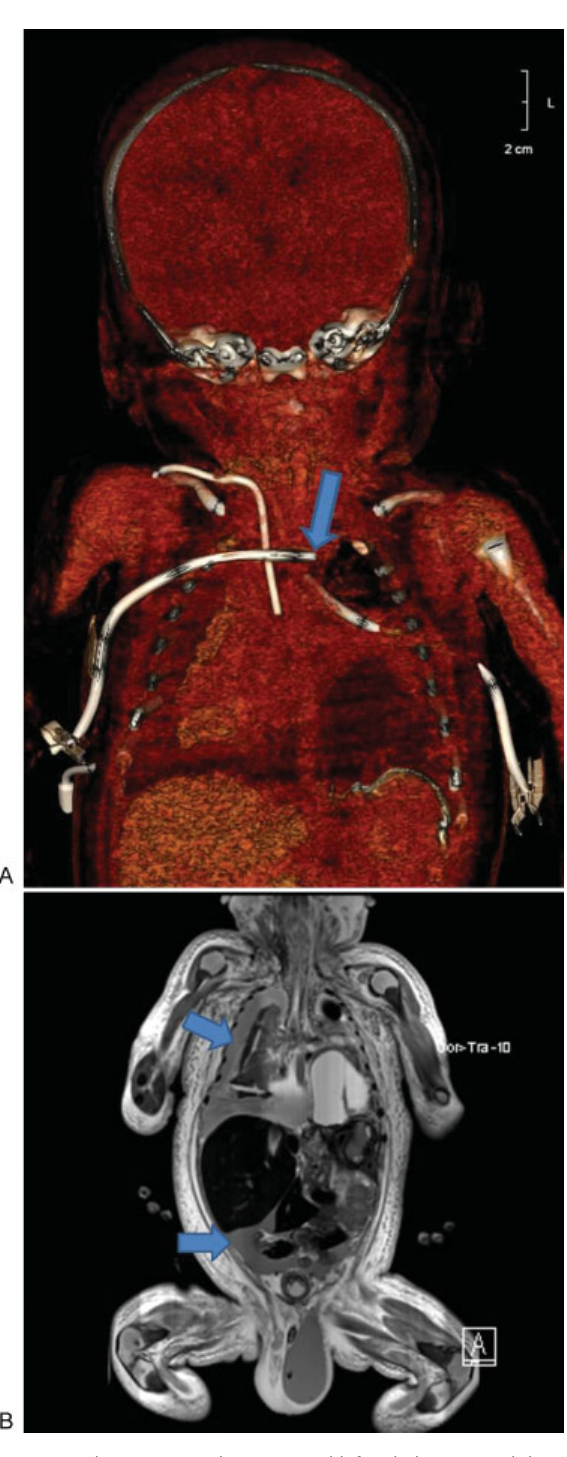
Fig. 2 A male neonate with a corrected left-sided congenital dia- phragmatic hernia. The right-sided chest drain was malpositioned through the mediastinum and caused a fatal hemorrhage. (A) The postmortem computed tomography and three-dimensional recon- struction shows the right-sided chest drain transversing the medias- tinum (arrow). (B) The postmortem magnetic resonance imaging demonstrates the extensive intrapleural and intraperitoneal hemor- rhage (arrows).